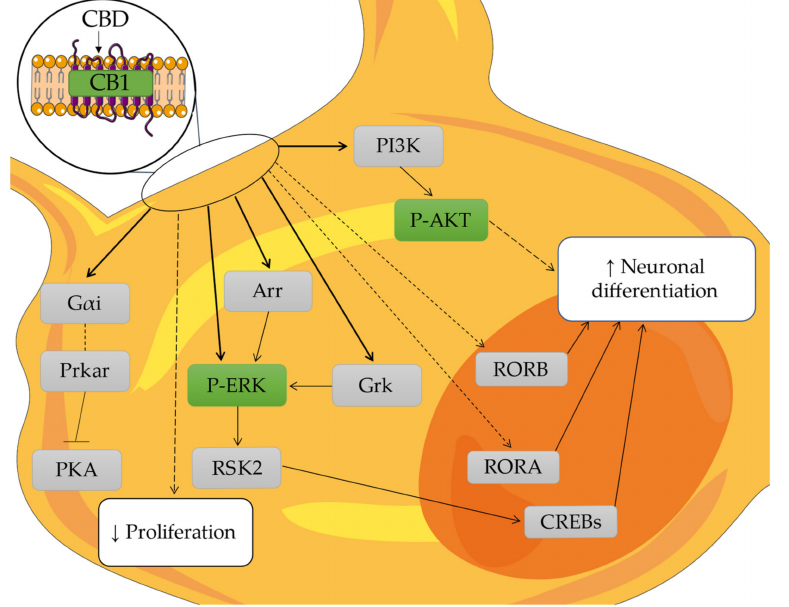
Figure 6. Proposed mechanism for the neurodifferentiation of NSC-34 with the CB1 signaling at 10 µ M CBD. The image shows the change inside the NSC-34. In green, the protein analyzed with WB is shown; in light gray, the proteins encoded by the genes analyzed with the transcriptomics analyses are shown; and in the white square, the biological process is shown. Continuous arrows indicate direct associations, while dashed arrows indicate indirect associations. Figure drawn using the vector image bank of Servier Medical Art by Servier (http://smart.servier.com/, accessed on 23 July 2022). Licensed under a Creative Commons Attribution 3.0 Unported License (https://creativecommons. org/licenses/by/3.0/, accessed on 23 July